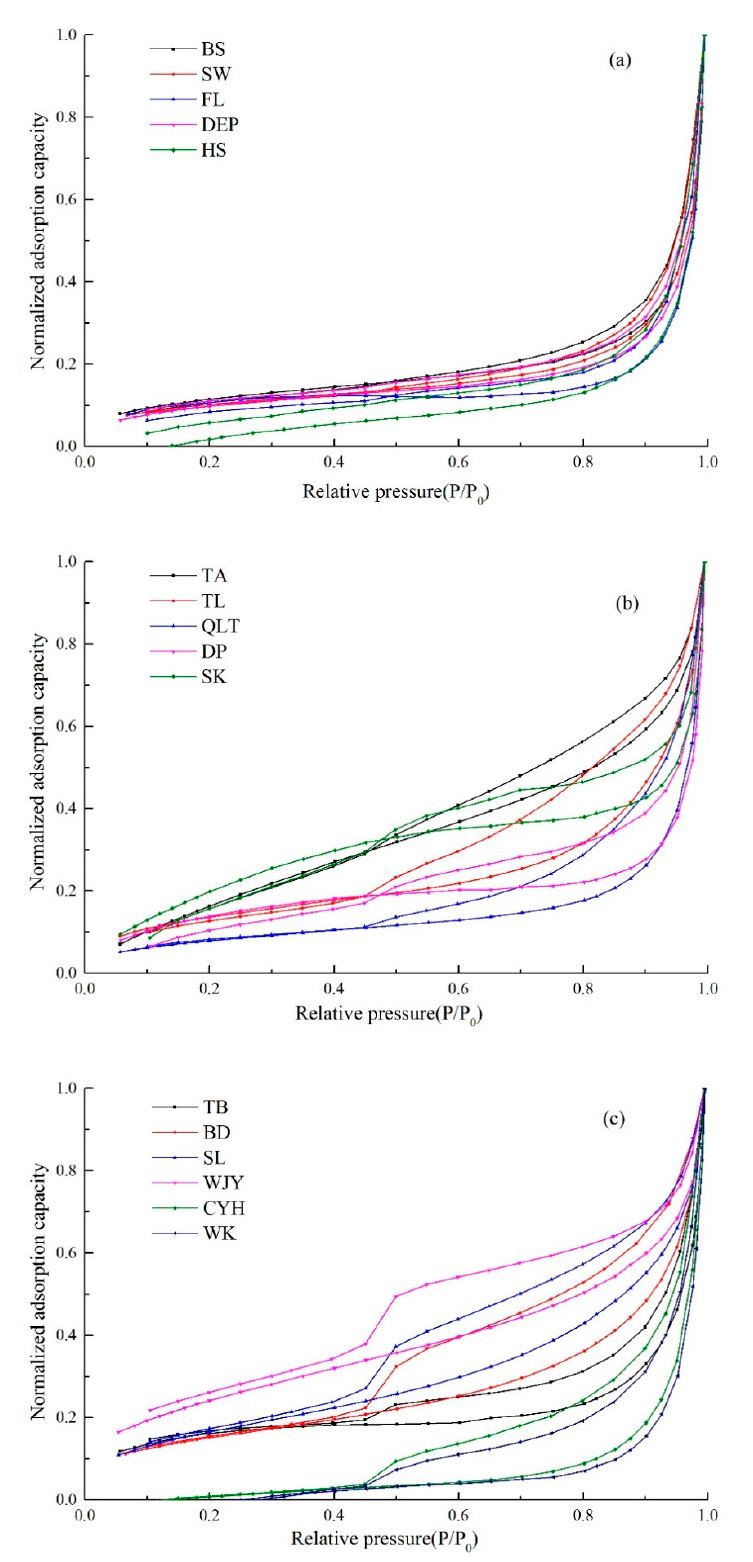
Figure 3. Low temperature nitrogen (N 2) adsorption loop type of selected coal samples (a: type I, b: type II, c: type III). ( b ) type II, ( c ) type